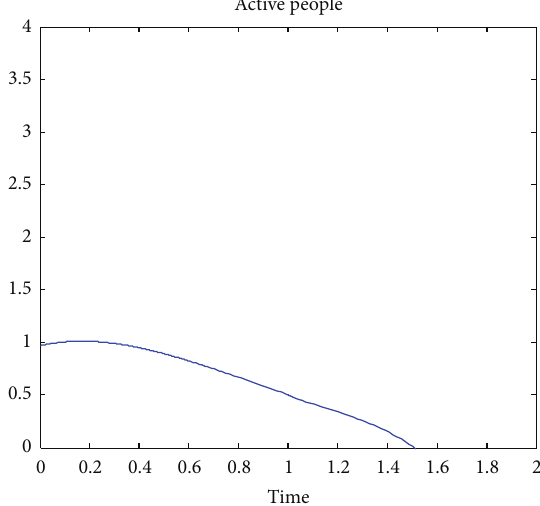
Figure 6: Approximate for 𝜇 = 0.45 , 𝜂 = 0.7 , and 𝜐 = 0.85 .